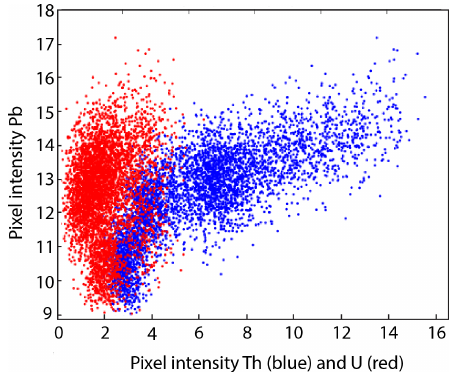
Figure A5. Scatter plot of Pb as a function of Th (blue) and U (red) in pixel intensities, corresponding to the scanned area illustrated in Fig.